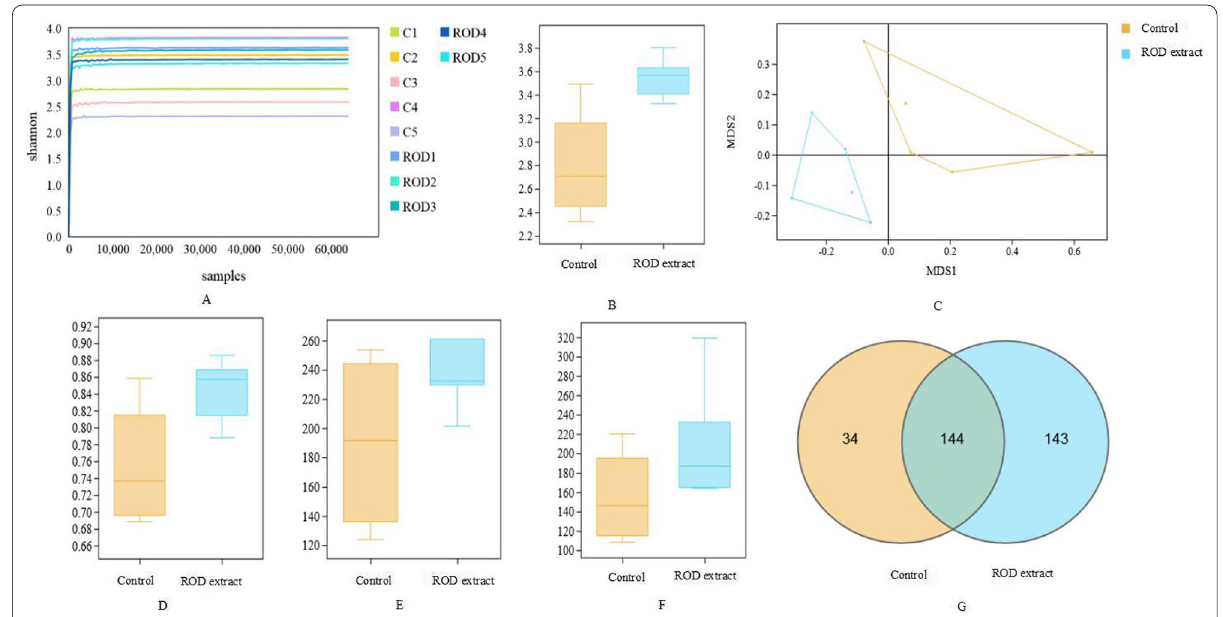
Fig. 1 The α- and β-diversity of ileal bacterial communities in finishing pigs in the both control and ROD polyphenol extract group. Shannon– Wiener curves of ileal microbiota of finishing pigs on day 15 were shown ( A ). Bacterial diversity between the control and ROD polyphenol extract groups was assessed by the Shannon index ( B ) and Simpson index ( D ). The NMDS comparative analyses of ileal bacterial community structure between the two groups on days 15 ( C ). Bacterial richness in the control and ROD polyphenol extract groups was estimated by the Chao1 ( E ) and Robs ( F ). Shared and unique ileal OTUs between control and ROD polyphenol extract group was indicated on Venn diagrams ( G